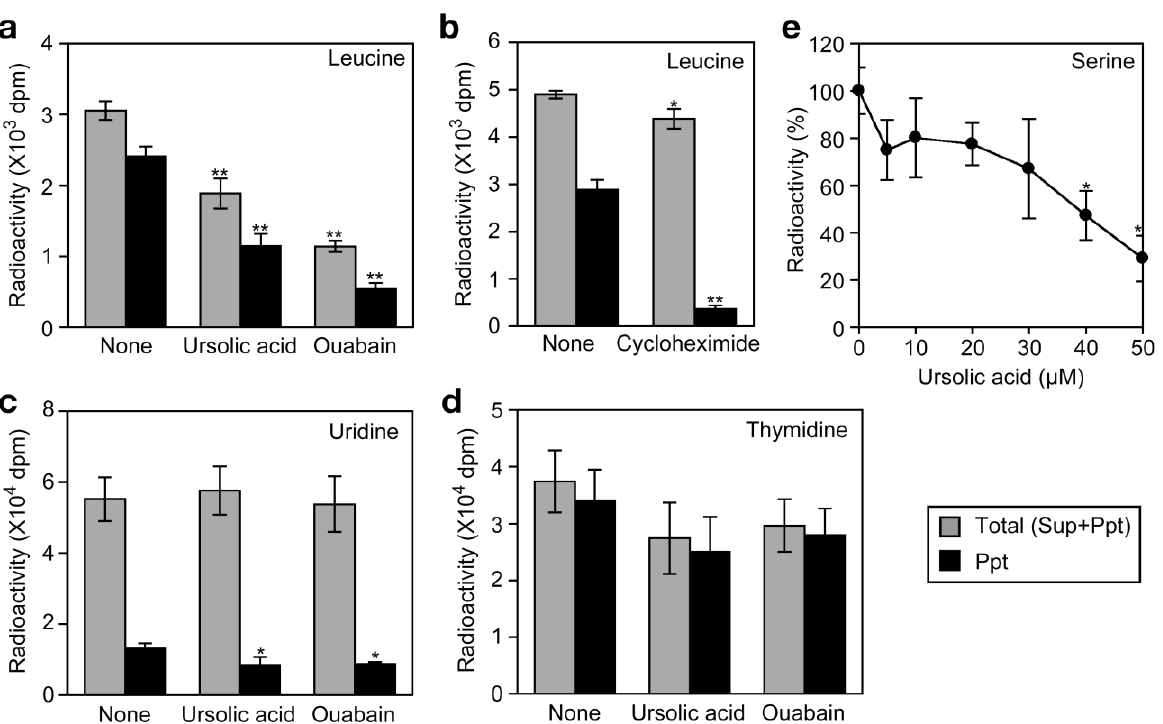
Figure 7. Ursolic acid selectively inhibits the incorporation of amino acids into the cell. ( a to d ) A549 cells were preincubated with or without ursolic acid (50 µM) or ouabain (10 µM) for 1 h and then incubated with [ 3 H] L -leucine for 2 h in the presence or absence of those two compounds ( a ); A549 cells were preincubated with or without cycloheximide (10 µM) for 1 h and then incubated with [ 3 H] L -leucine for 2 h in the presence or absence of cycloheximide ( b ); A549 cells were preincubated with or without ursolic acid (50 µM) or ouabain (10 µM) for 1 h and then incubated with [ 3 H]uridine ( c ) or [ 3 H]thymidine ( d ) for 2 h in the presence or absence of those two compounds. Radioactivity incorporated into the cell was separated into acid-soluble supernatants (Sup) and acid-insoluble precipitates (Ppt). Total radioactivity incorporated into the cell (Sup+Ppt; gray bars) as well as radioactivity incorporated into the precipitates (Ppt; filled bars) is shown as means ± SD (n = 3). * P < 0.05 and ** P < 0.01, compared with control; ( e ) A549 cells were preincubated with various concentrations of ursolic acid for 1 h and then pulse-labeled with [ 3 H] L -serine for 5 min in the presence of ursolic acid. Radioactivity incorporated into the cell was measured. Data points represent means ± SD (n = 3). * P < 0.01, compared with